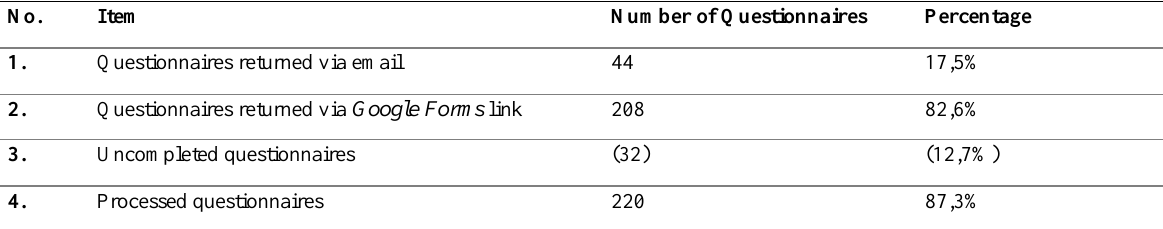
Table 1: Questionnaire Distribution and Return